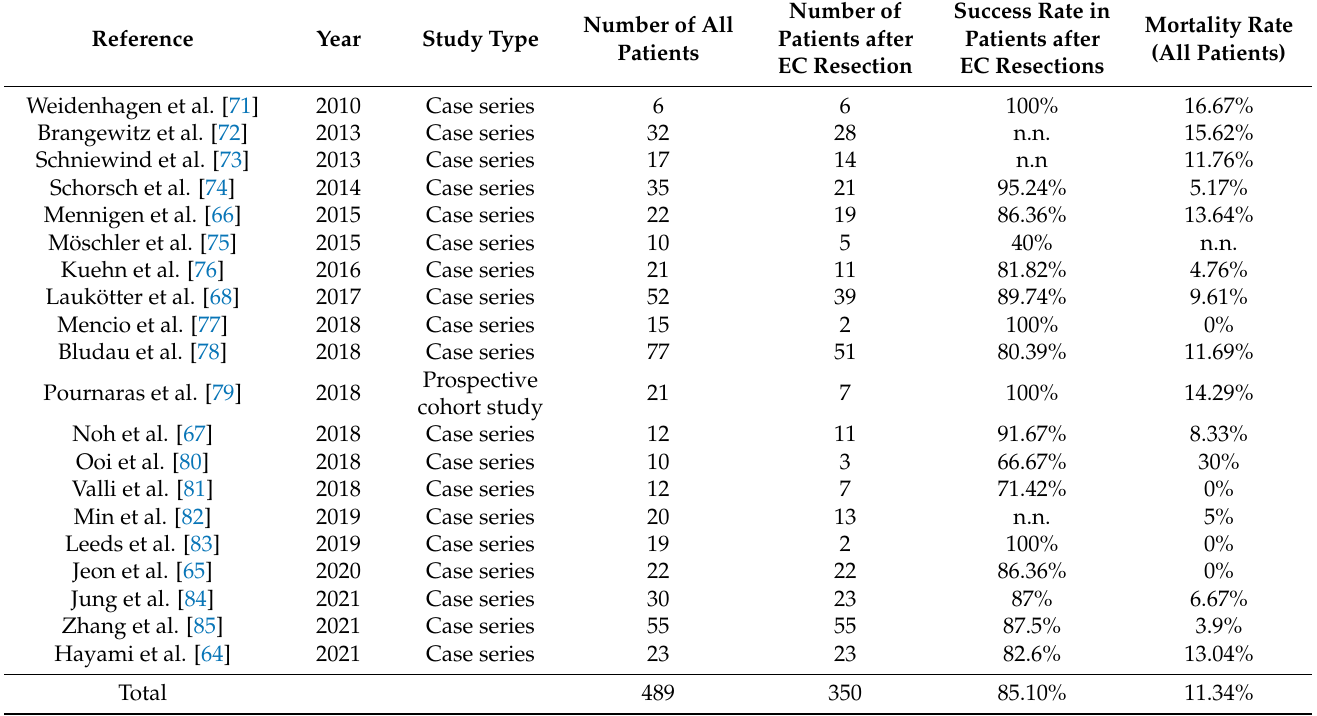
Table 2. Publications with more than five patients on ENPT in patients with AI after EC